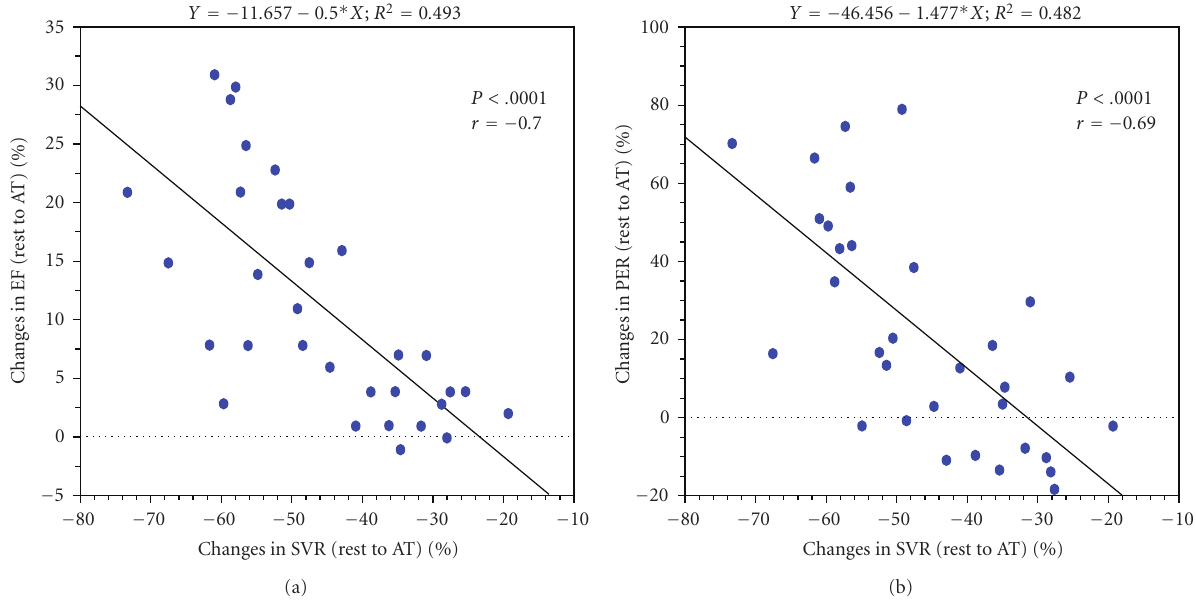
Figure 1: The correlation between the percent changes in systemic peripheral vascular resistance and cardiac response to exercise. EF: left ventricular ejection fraction; SVR: systemic peripheral vascular resistance; AT: anaerobic threshold; PER: peak ejection rate.